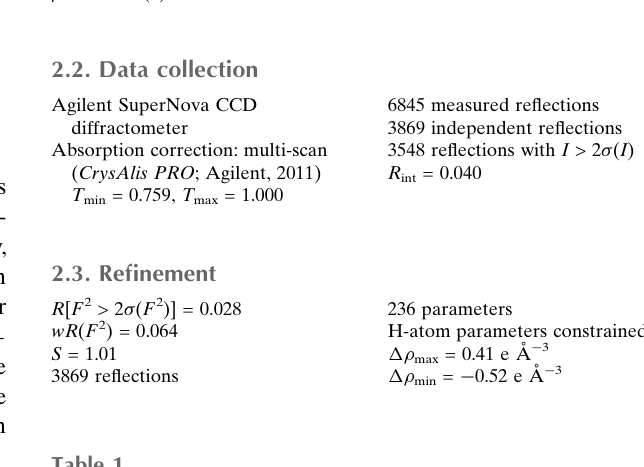
Hydrogen-bond geometry (A˚ , (cid:2) ). Cg 1 is the centroid of the C1–C6